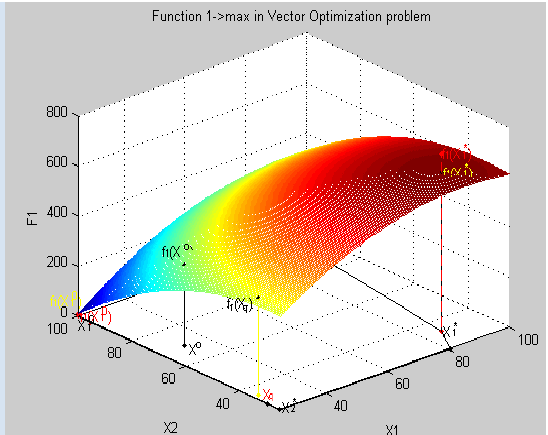
Figure 9. The first characteristic f 1 ( X ) of the technical system in a natural indicator.